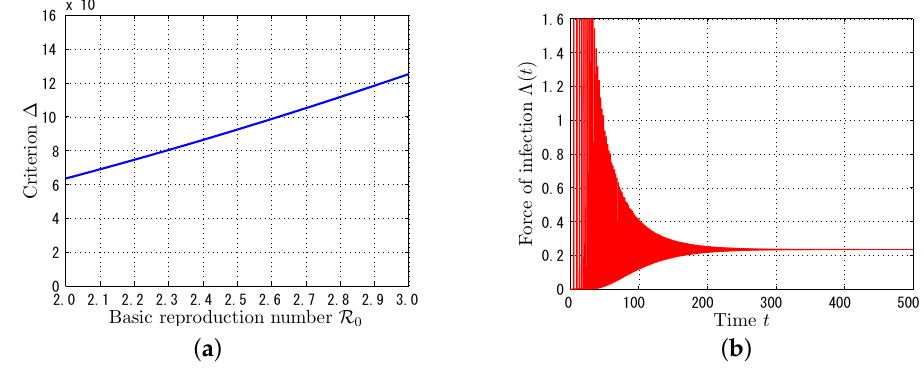
Figure 1. Numerical confirmation of condition (17) and asymptotic stability of the endemic equilibrium E ∗ for the case of an influenza-like disease: ( a ) Variation of ∆ defined in (17) for 2 = 2.5. variation of Λ ( t ) for R 0